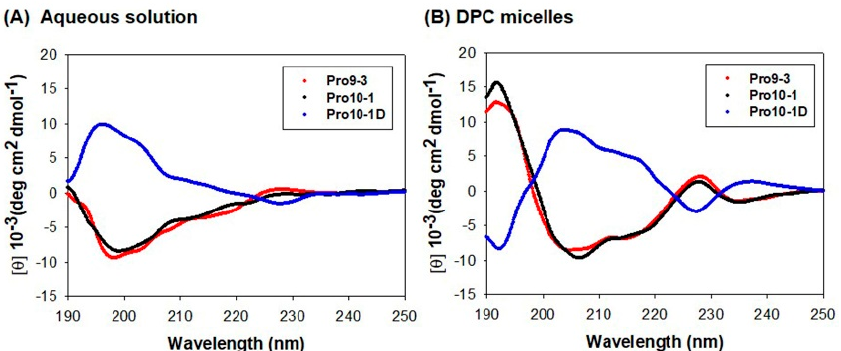
Figure 3. Circular dichroism spectra of Pro9-3 and its analogs at 100 µM in ( A ) aqueous solution and ( B ) 50 mM dodecylphosphocholine (DPC) micelles acquired with 10 scans: Double negative maxima at 205 and 220 nm are characteristic of α -helical structures.